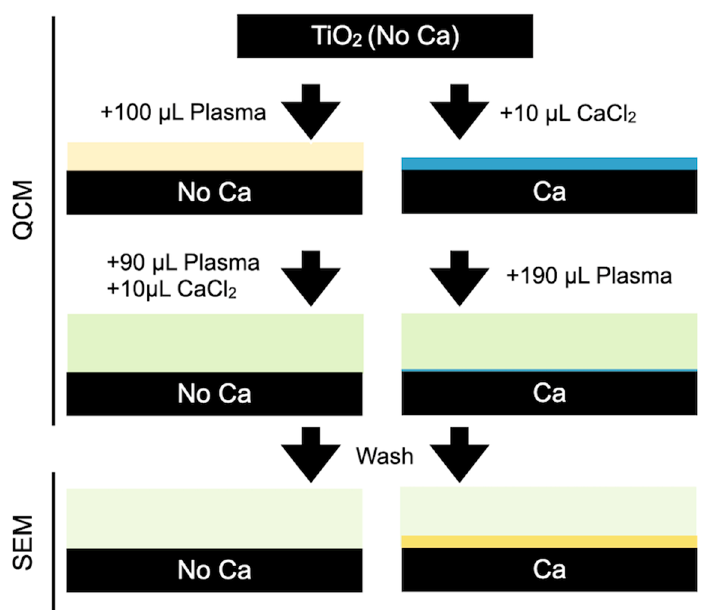
Figure 1. Scheme of the QCM